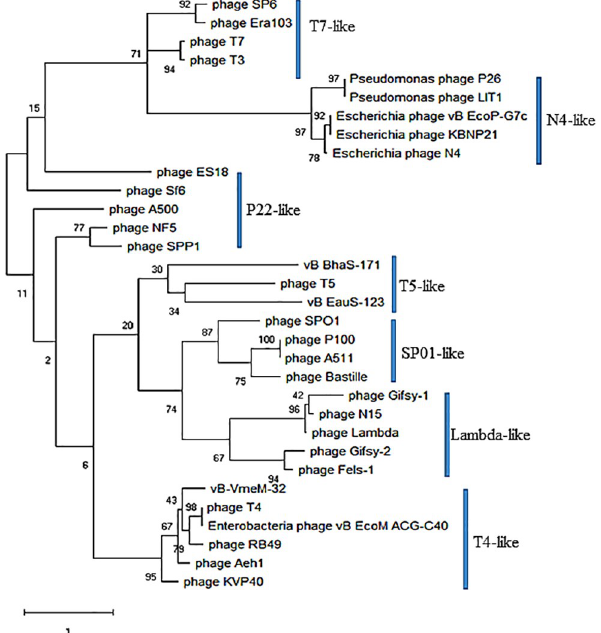
Fig 6. Phylogenetic analysis of large terminase subunits compared to phages with known DNA packaging strategies. The maximum—Likelihood tree was inferred based on ClustalW alignment of large terminase subunits amino acid sequences. The tree was rooted via midpoint rooting. The numbers at the nodes represent bootstrap values based on 1,000 resamplings.